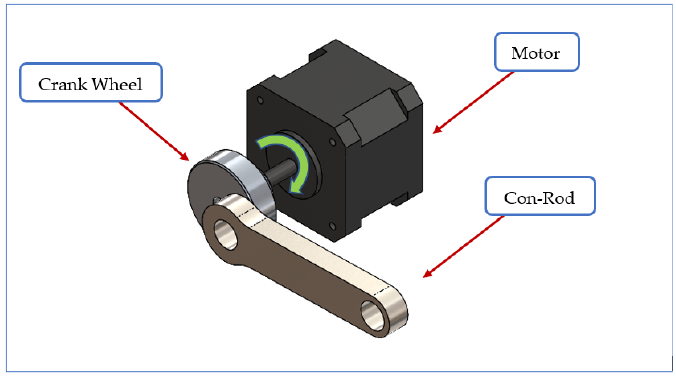
Figure 3. Motor and crank mechanism.